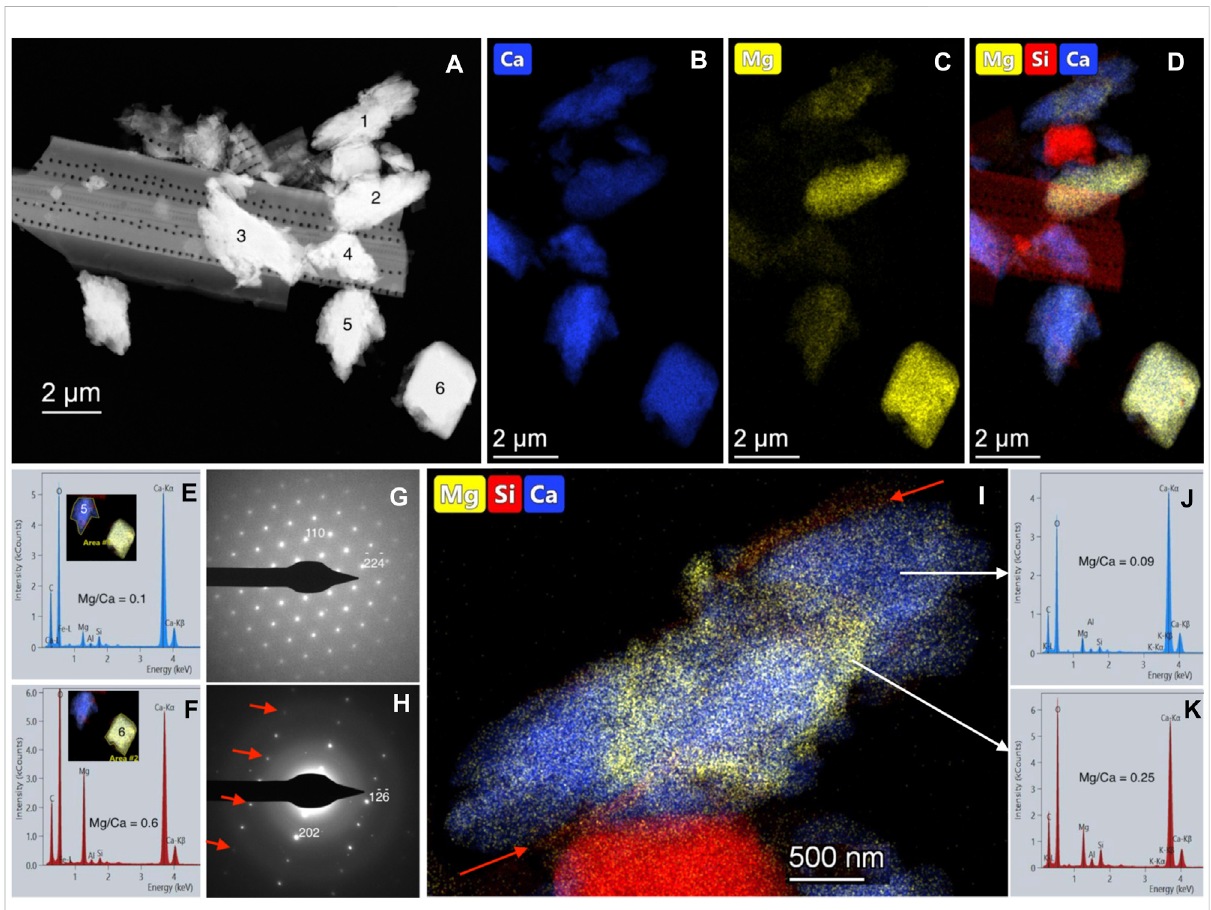
FIGURE 8 TEM analysis of typical autochtonous carbonate particles in Lake Balaton. (A) High-angle annular dark- fi eld (HAADF) STEM image of carbonate particles (numbered) and a larger diatom fragment from suspended matter. (B – D) Ca, Mg, and combined Ca+Mg+Si energy-dispersive STEM X-ray spectrometry(EDS) element maps. (E) and (F) EDS spectra and Mg/Ca mol ratios of particle #2 (Mg-bearing calcite) and particle #6 (protodolomite), respectively. (G – H) Selected-area electron diffraction (SAED) patterns of particles #2 and #6; the red arrows mark rows of re fl ections that are forbidden by the calcite space group; they could arise either from multiple diffraction effects or from the ordering of Mg and Ca in particle #6. (I) Composite of Ca, Mg and Si maps of particle #1. The red arrows mark fl akes of smectite. (J – K) EDS spectra and Mg/Ca ratios of selected Mg-poor and Mg-rich regions (as indicated by the white arrows in (I) in particle